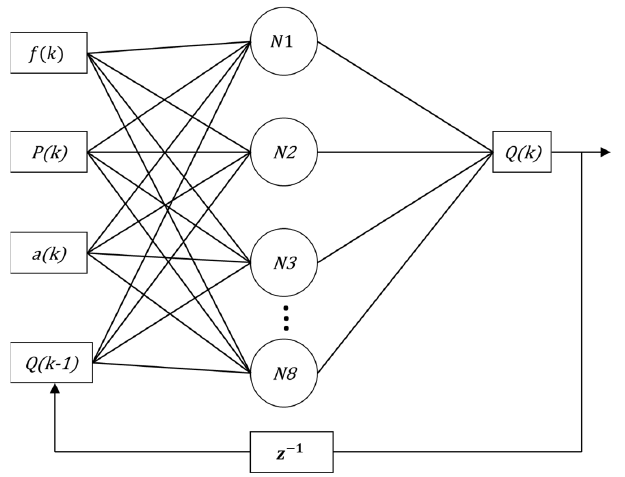
Figure 12. Diagram of NARX ANN with feedback, with four input vectors, eight neurons and an output.